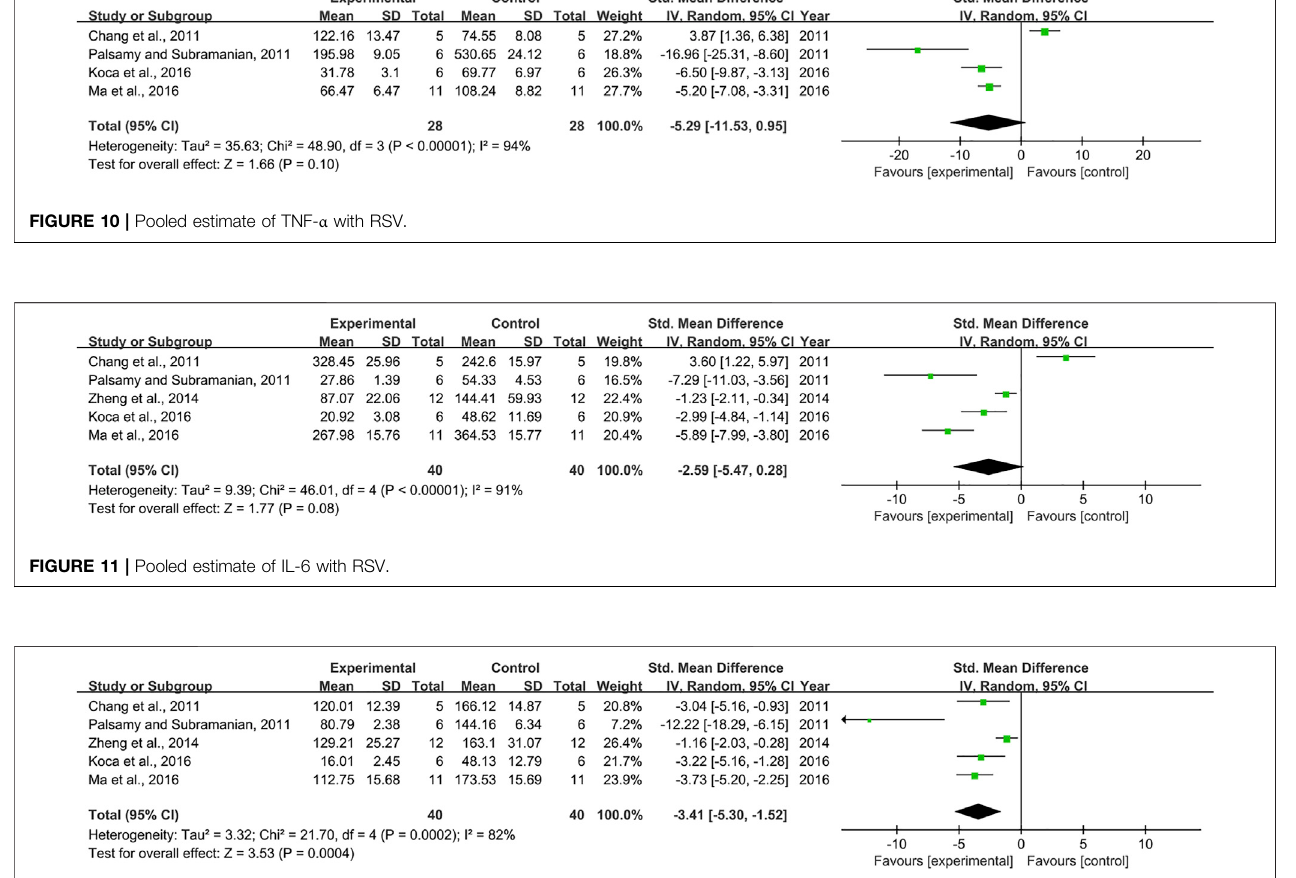
FIGURE 12 | Pooled estimate of IL-1 β with